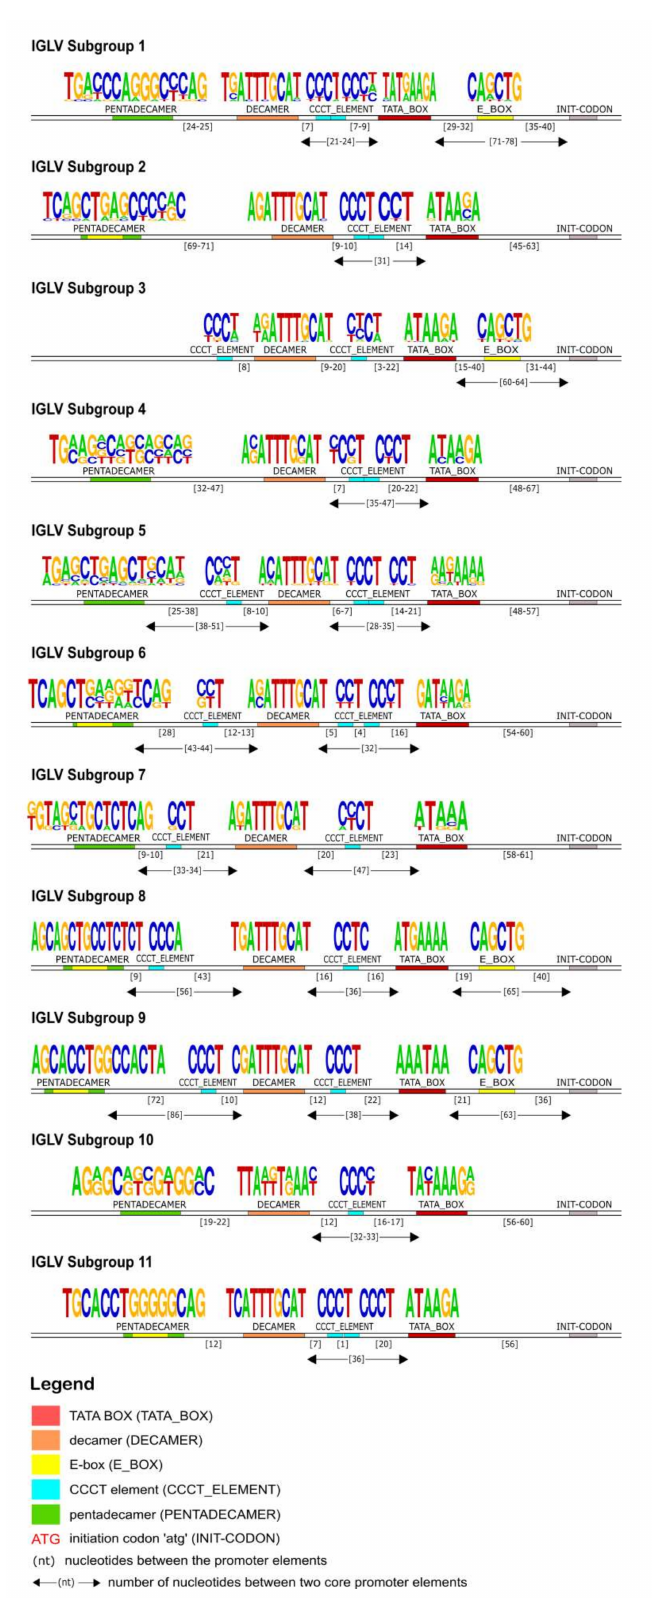
Figure 7. Schematic representation of the IGLV genes promoter organization per subgroup, based on the regulatory elements consensus sequences, positions and distances. Each element is represented by a specific color according to the IMGT color menu for the organization of the V-GENE promoters. The IMGT labels of each element are mentioned in parentheses in the